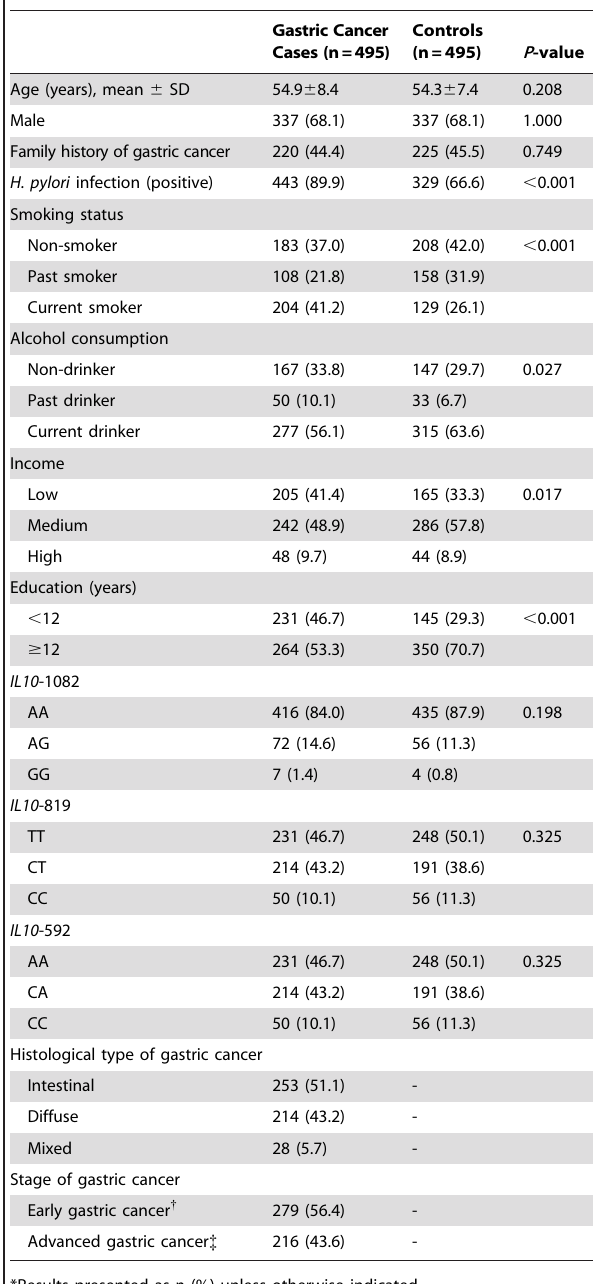
Table 1. Characteristics of the Study Subjects*.